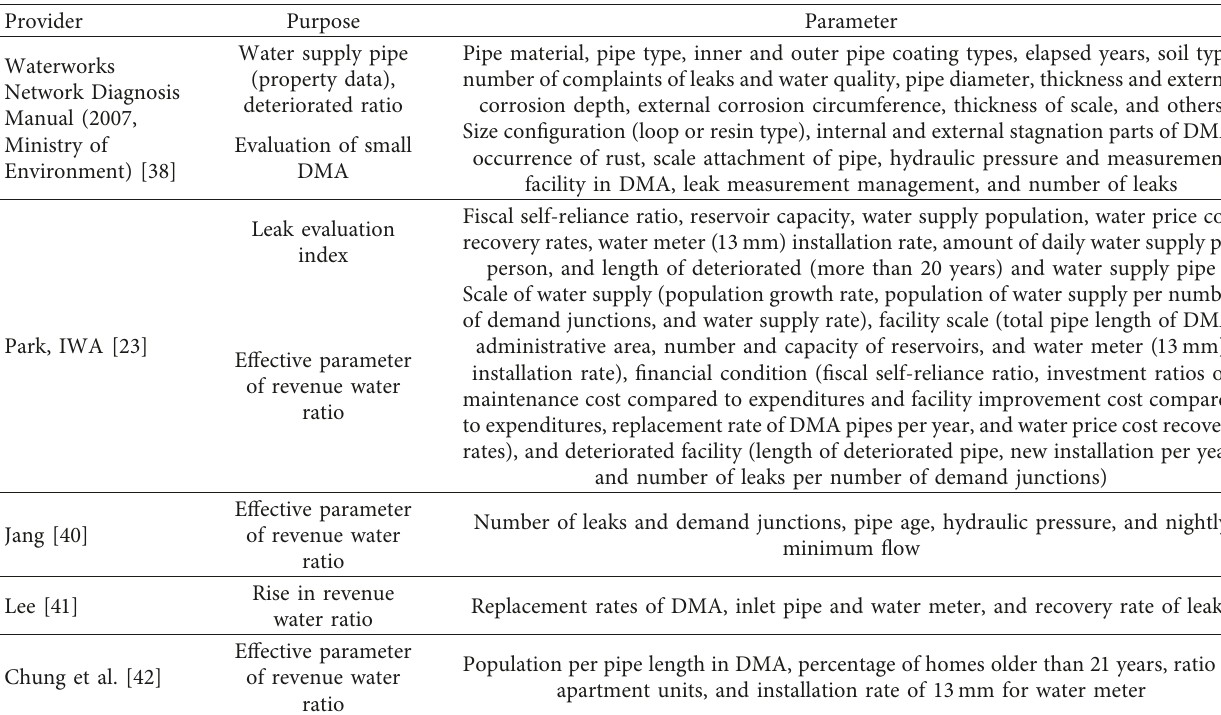
Table 4: Classification of main parameters in water distribution systems [4, 8,